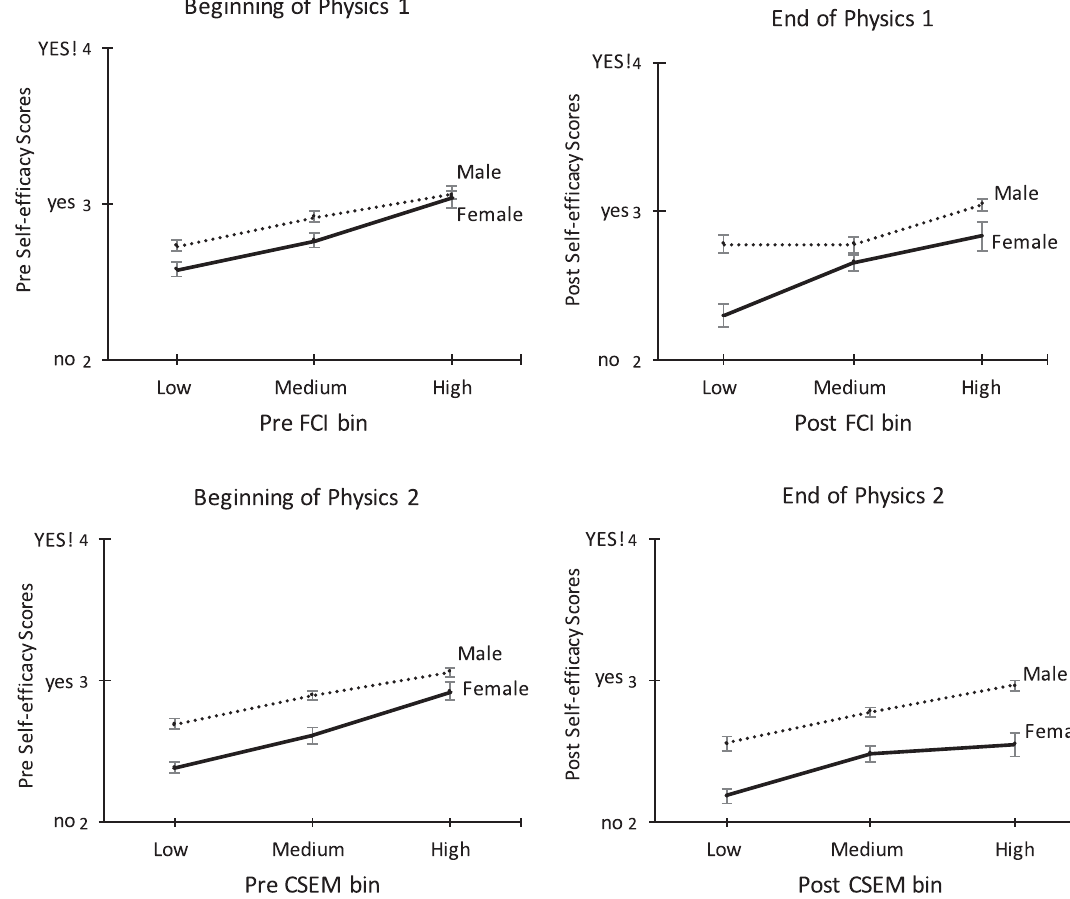
FIG. 1. Pre-self-efficacy (left column) and post-self-efficacy (right column) scores of female and male students binned by temporally proximal conceptual test score in physics 1 (top row) and physics 2 (bottom row) courses. Error bars represent standard error of the